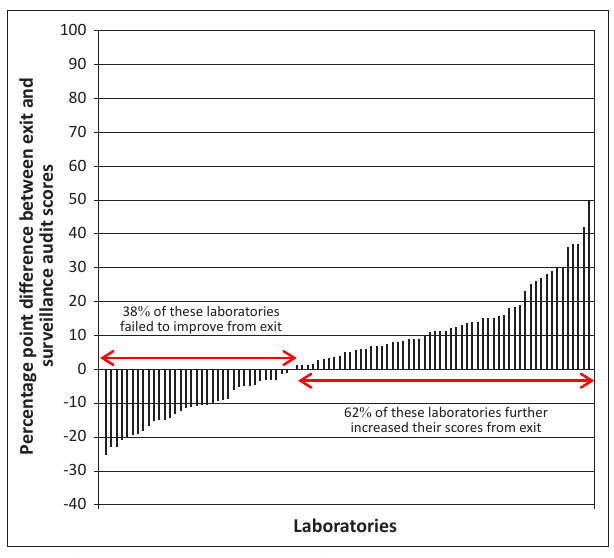
FIGURE 4: Post-SLMTA surveillance audits ( n = 92 laboratories), based on the Stepwise Laboratory Quality Improvement Process Towards Accreditation checklist.